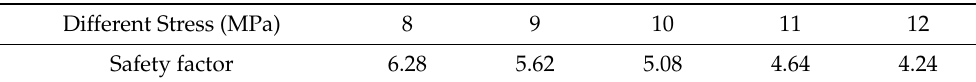
Table 5. Safety factors for different inside pressures (Uniform tubing diameter of 3- 1 / 2 (cid:48)(cid:48) , pump shutdown time of 6